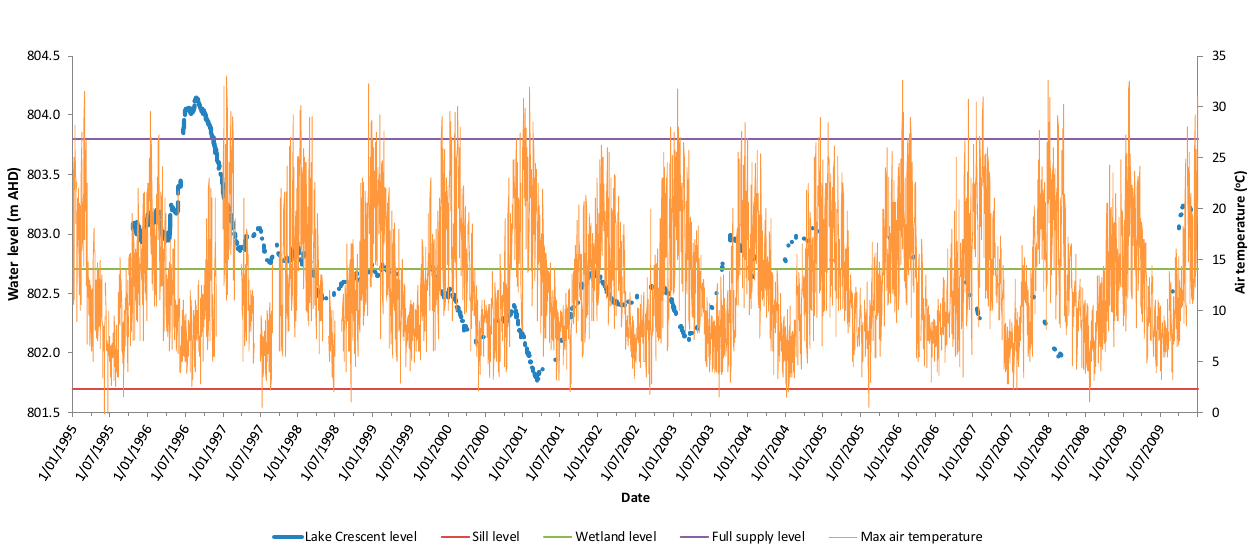
Figure A1. Lake Crescent lake levels from 1995 to 2009, in relation to the full supply, wetland, and sill levels of the lake. Daily maximum air temperature taken from Lake St Clair National Park is also plotted in conjunction (Downloaded from www.bom.gov.au). Note: Lake level data is deficient at certain periods.